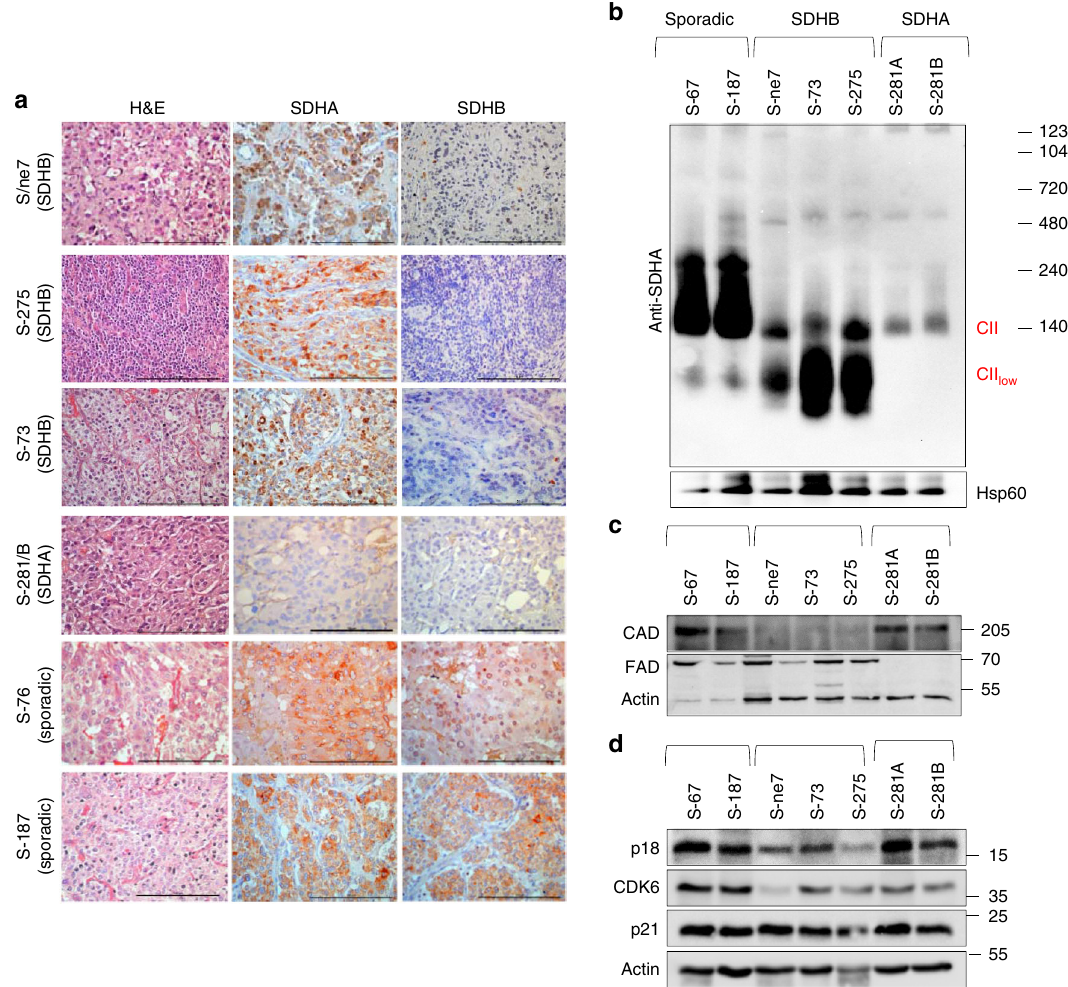
Fig. 8 CII assembly and de novo pyrimidine pathway in paragangliomas. a Histological examination of SDHA and SDHB expression from tumor tissue of paraganglioma patients with SDHA or SDHB mutations or with sporadic paragangliomas. Tissues were processed for H&E staining and immunohistochemistry using SDHA and SDHB IgGs. Representative images are collected using a 40× objective. Scale bars represent 100 μ m. b – d Paraganglioma tissues, as shown, were assessed by WB following protein separation by NBGE for CII assembly using anti-SDHA IgG ( b ), and by SDS-PAGE for CAD and FAD ( c ) and for markers of cell cycle ( d ). Images are representative of three independent